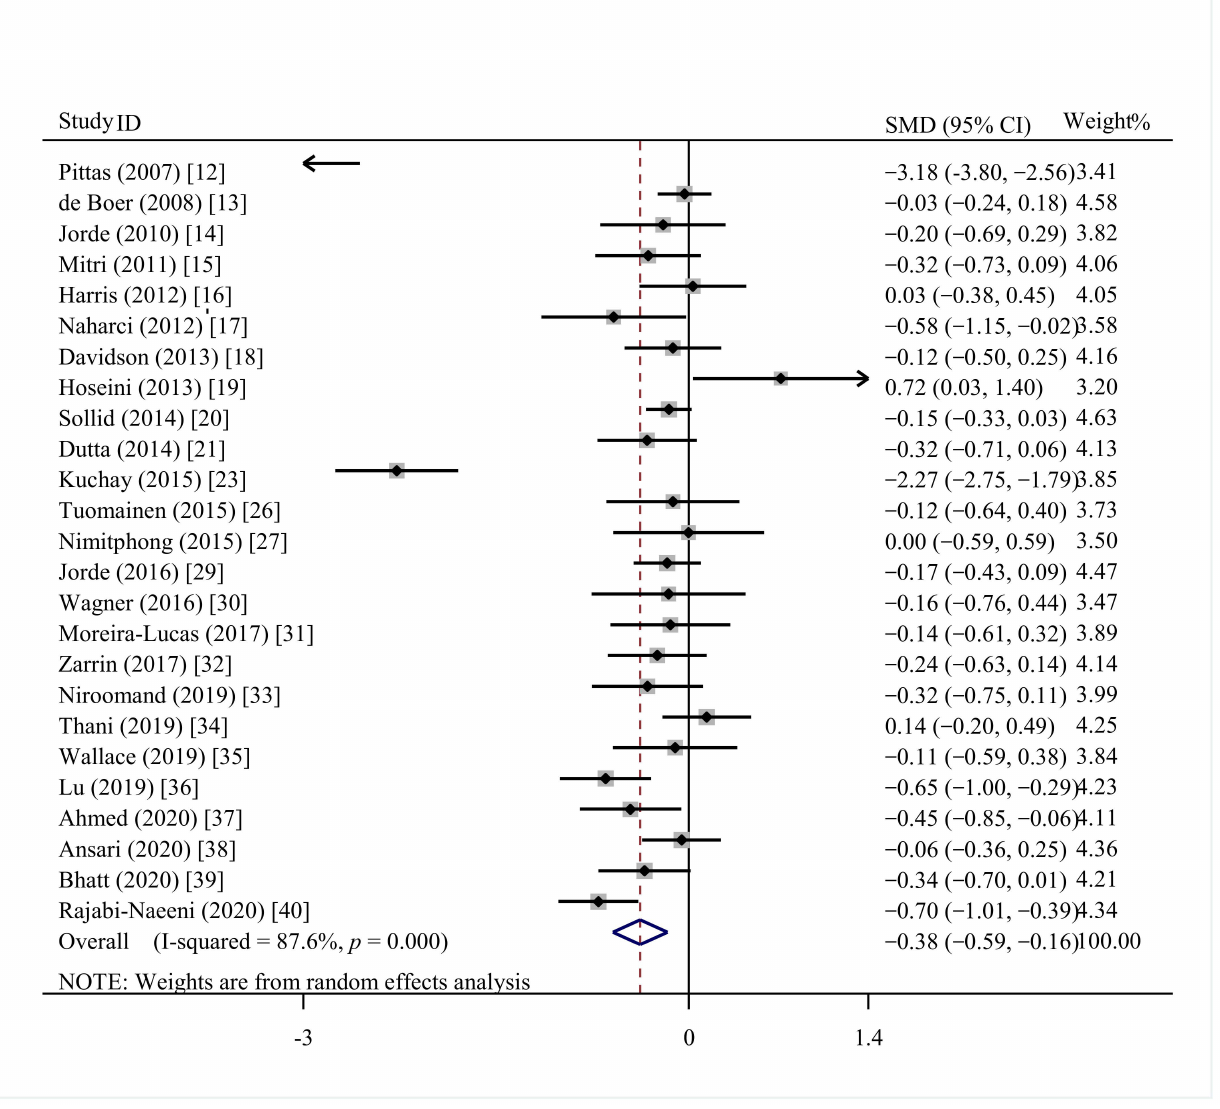
Figure 3. Effect of vitamin D supplementation on glycosylated hemoglobin A1c in